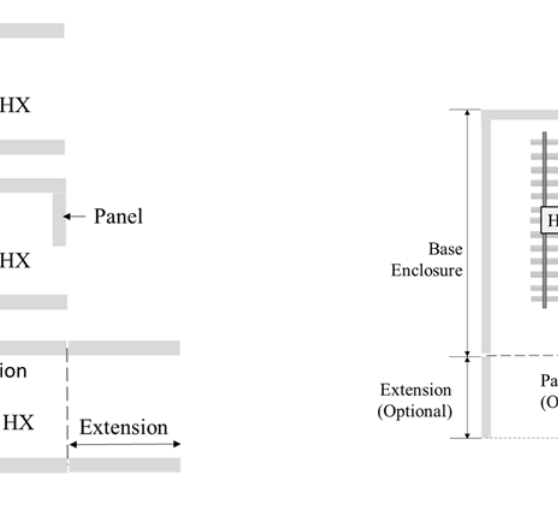
Figure 3. Schematic diagram of the heat exchanger (figure not drawn to scale).